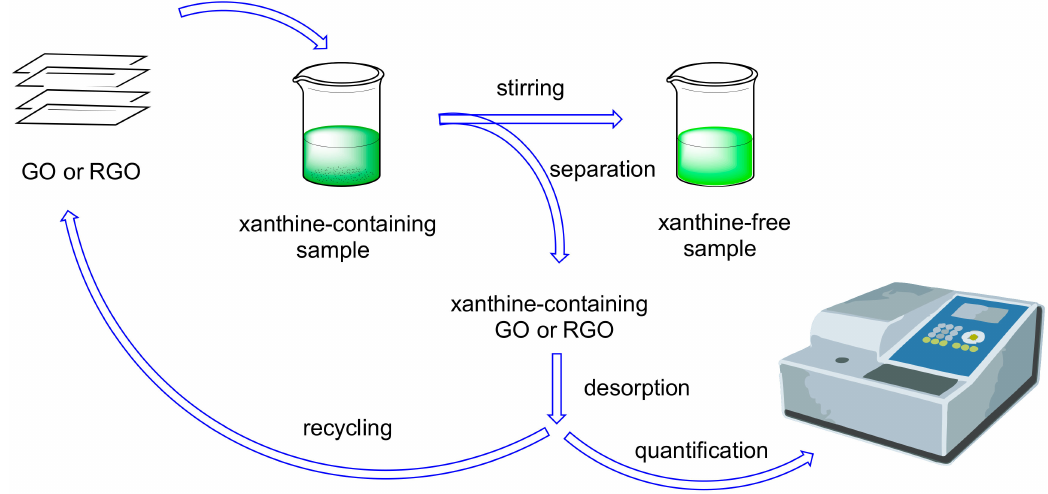
Figure 3. Use of GO or RGO as methylxanthines